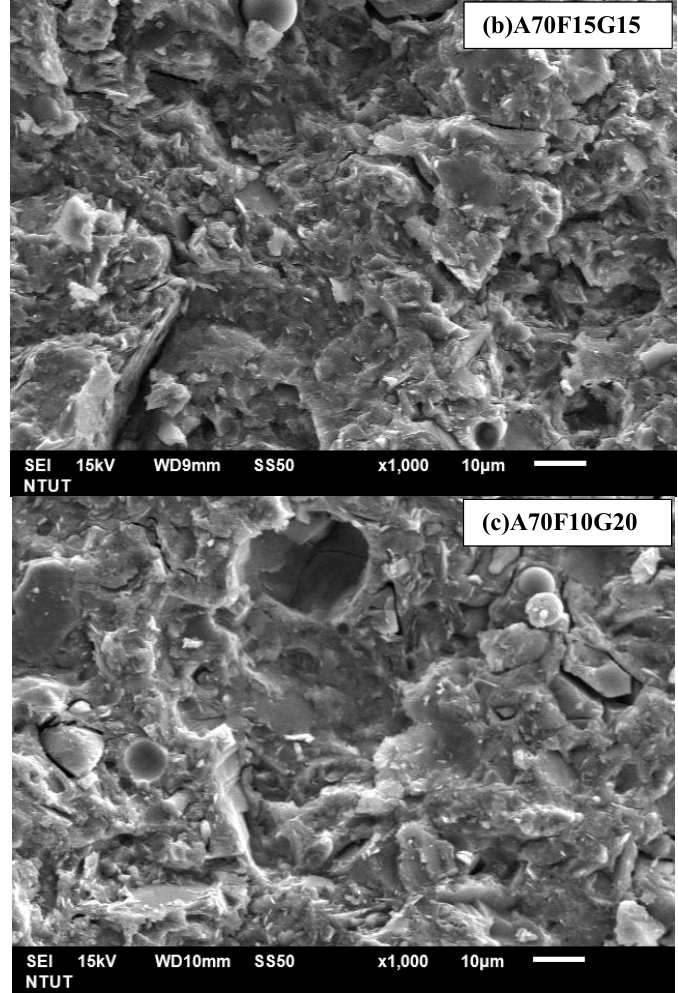
Figure 11. SEM Images of specimens with ( a ) FA20% GGBFS10% ( b ) FA15% GGBFS15%, and ( c ) FA10% GGBFS20%.